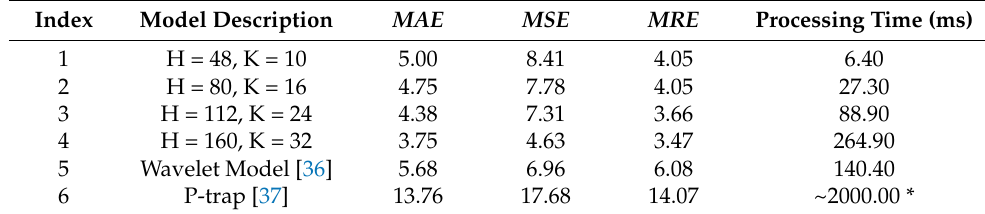
Table 4. Grain number prediction results of different models with difference processing